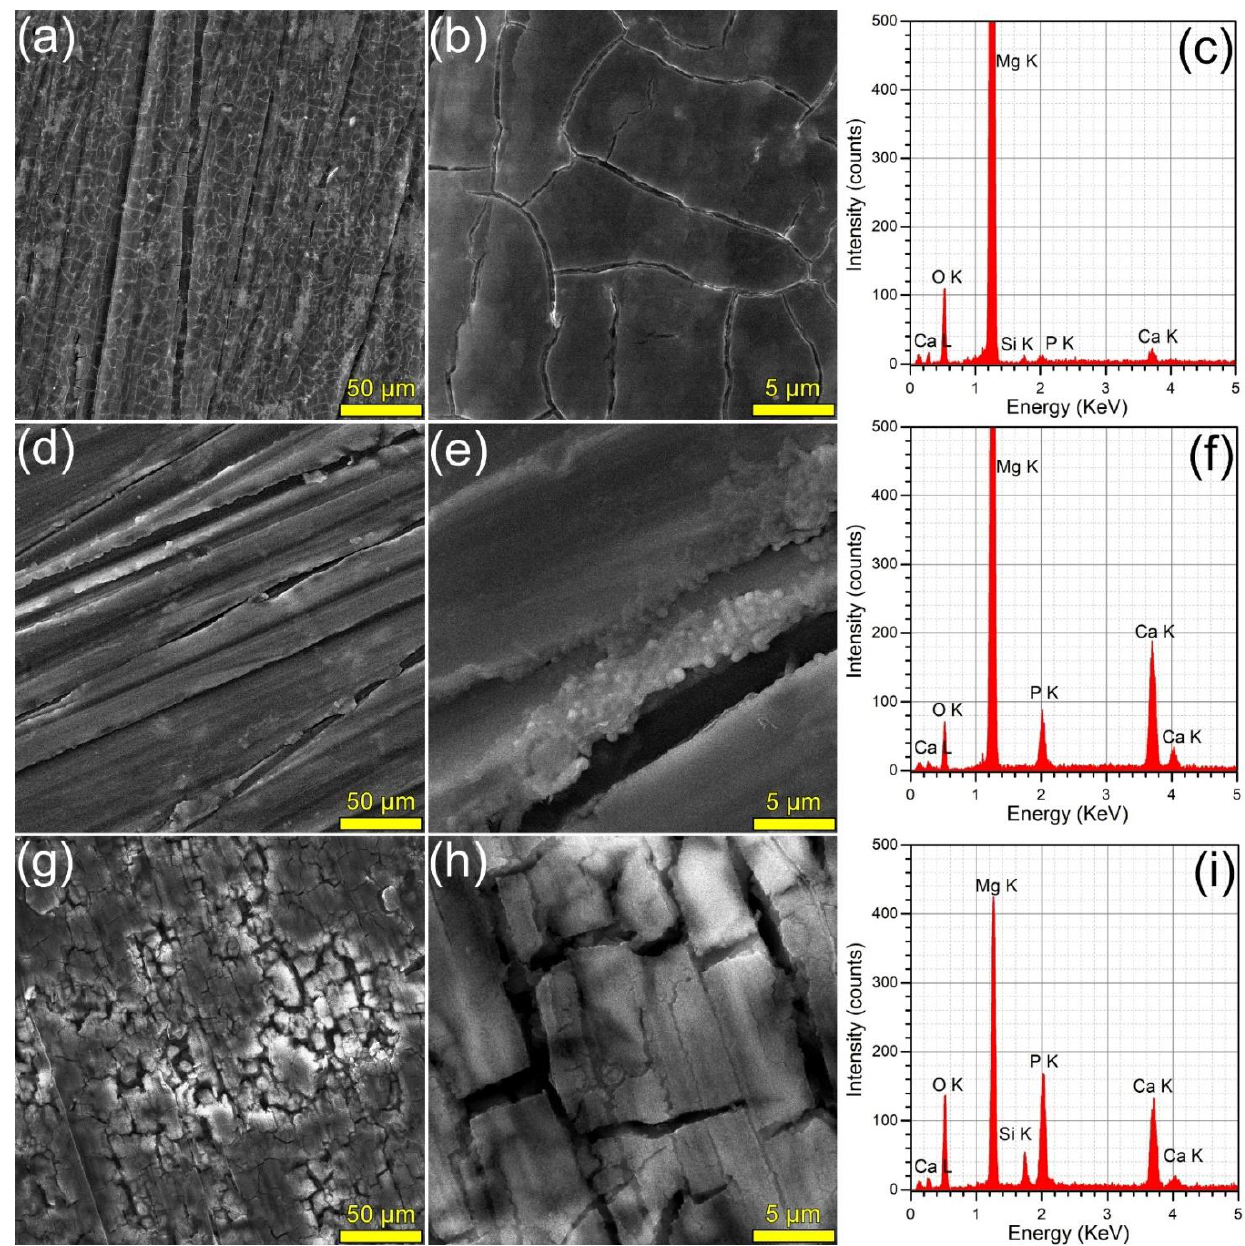
Figure 8. ( a , b , d , e , g , h ) SEM images and ( c , f , i ) EDS spectra collected subsequent to the corrosion tests performed in DMEM, on the ( a – c ) bare and ( d – f ) HA2- and ( g – i ) BG2-coated Mg-0.8Ca specimens.